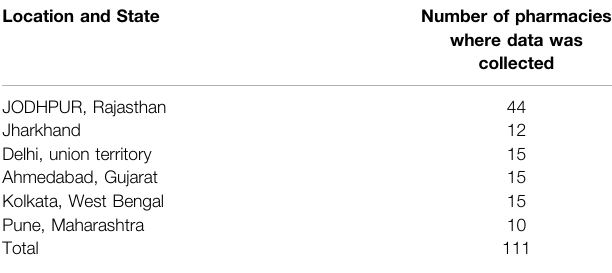
TABLE 3 | Community Pharmacy location in India. Location and